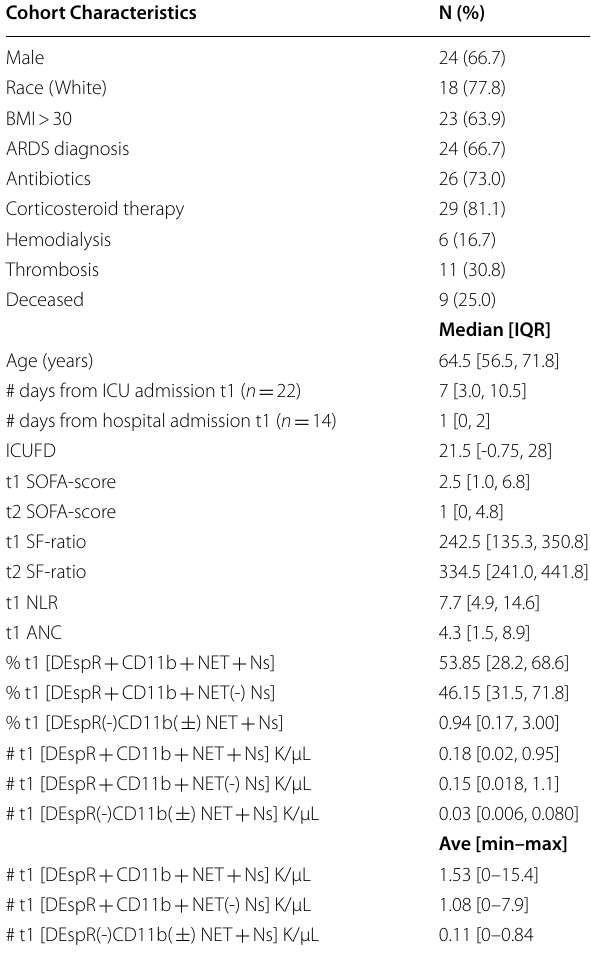
Table 1 Summary of COVID‑19 cohort